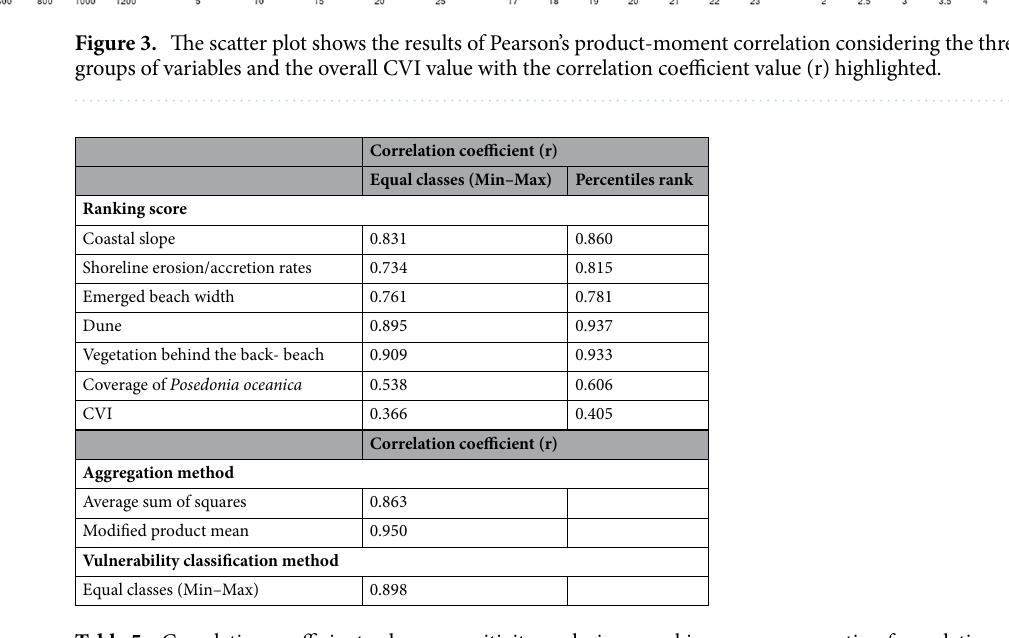
Table 5. Correlation coefficient values—sensitivity analysis on ranking score, aggregation formulation and vulnerability classification